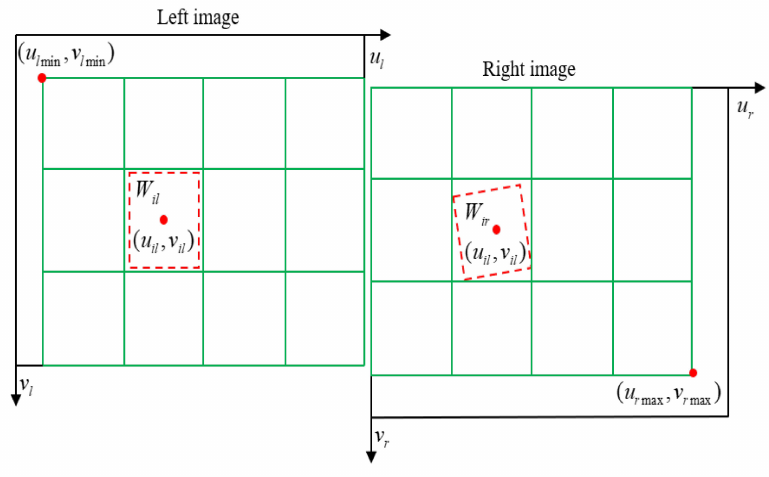
Figure 1. Gridding image and identification of corresponding